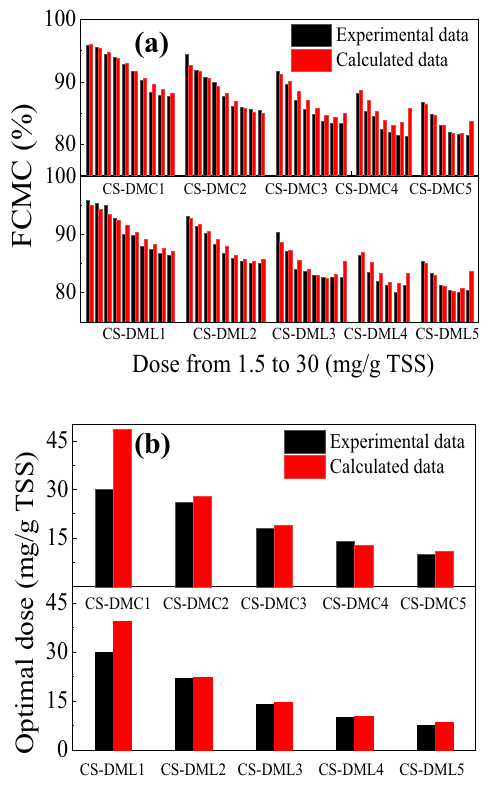
Figure 6. Comparison of the experimental and calculated ( a ) FCMC and ( b ) optimal doses of various St-based flocculants based on Eqs. (1)–(6) in the sludge